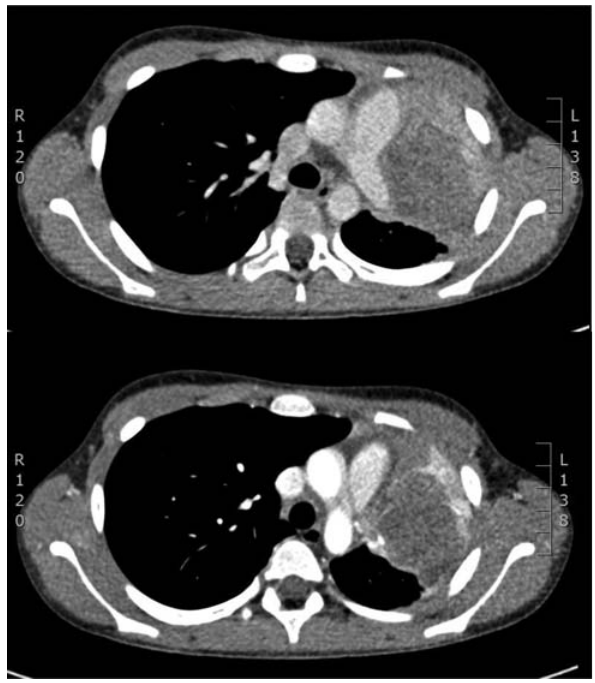
Fig. 1 Preoperative computer tomography showing the